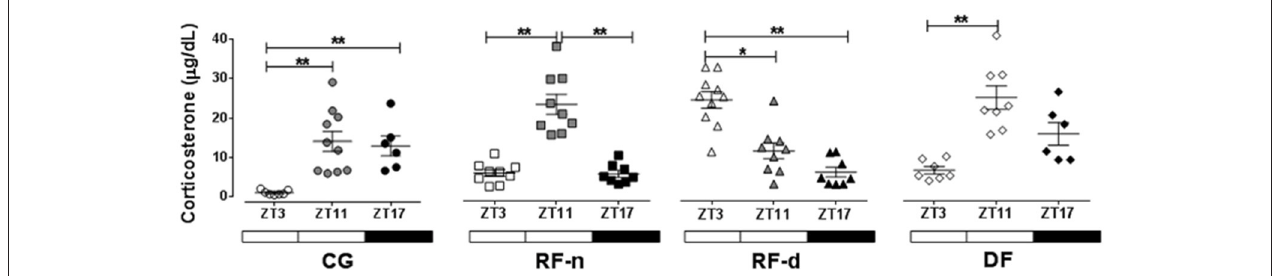
FIGURE 2 | Plasma corticosterone ( µ g/dl) in the control group (circles) with food ad libitum , restricted night-fed group (RF-night, squares) with access to food restricted to ZT12 to ZT14 (1800–2000h), restricted day-fed group (RF-day, triangles) with access to food restricted to ZT3–ZT5 (0900–1100h) and, restricted day-fed group (DF, diamonds) with access to food restricted to ZT0 to ZT12 (0600–1800h) at ZT3, ZT11, and, ZT17 (black symbols), corresponding to 900, 1700, and 2300h; respectively. N = 6–10 rats per time point per group. ZT, Zeitgeber Time. Significant difference among ZTs within the same feeding condition: * P < 0.05, ** P <